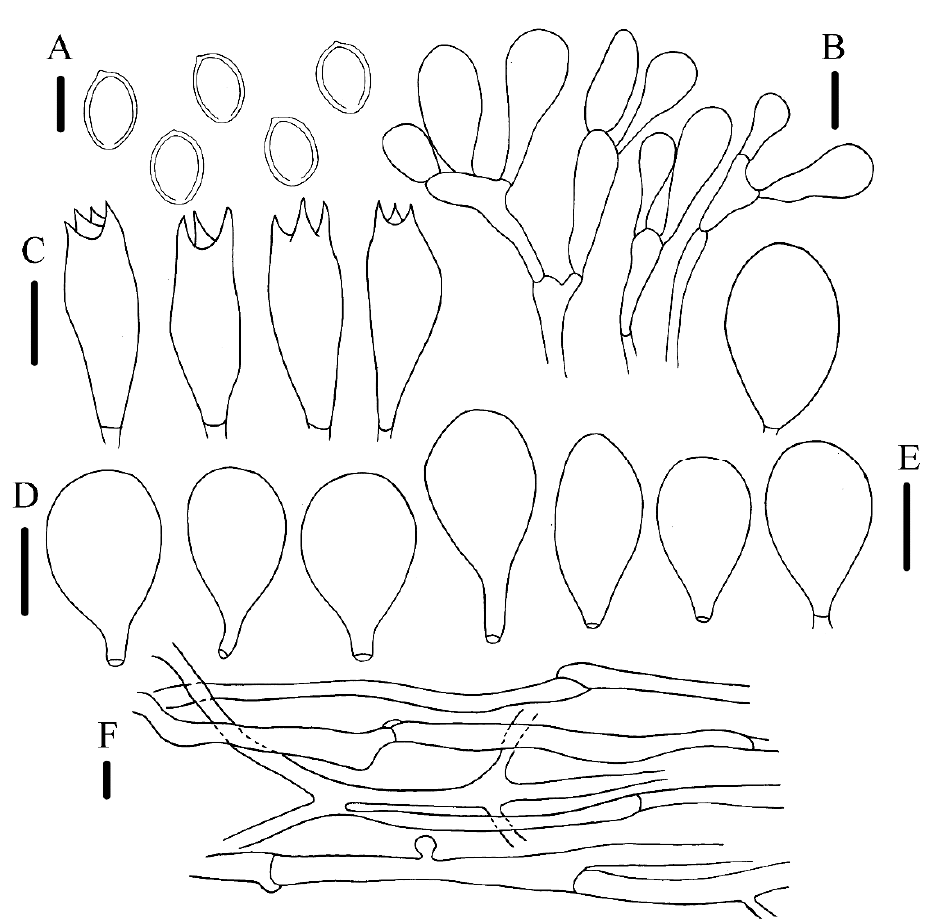
Figure 3. Micromorphology of A. striatipes (HMAS486942, holotype). ( A ) basidiospores; ( B ) pileipellis hyphae; ( C ) basidia; ( D , E ) cheilocystidia and pleurocystidia; ( F ) stipitipellis hyphae. Scale bar: ( A – F ) = 5 µm.